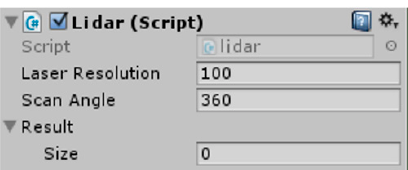
Figure 3. Schematic diagram of 2D LiDAR detection.